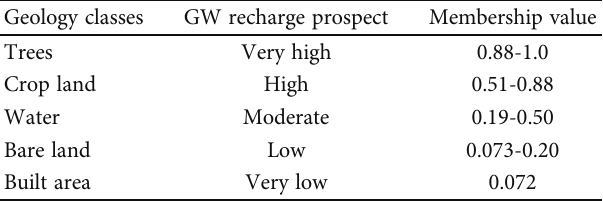
Table 6: Geology classes, membership value, and